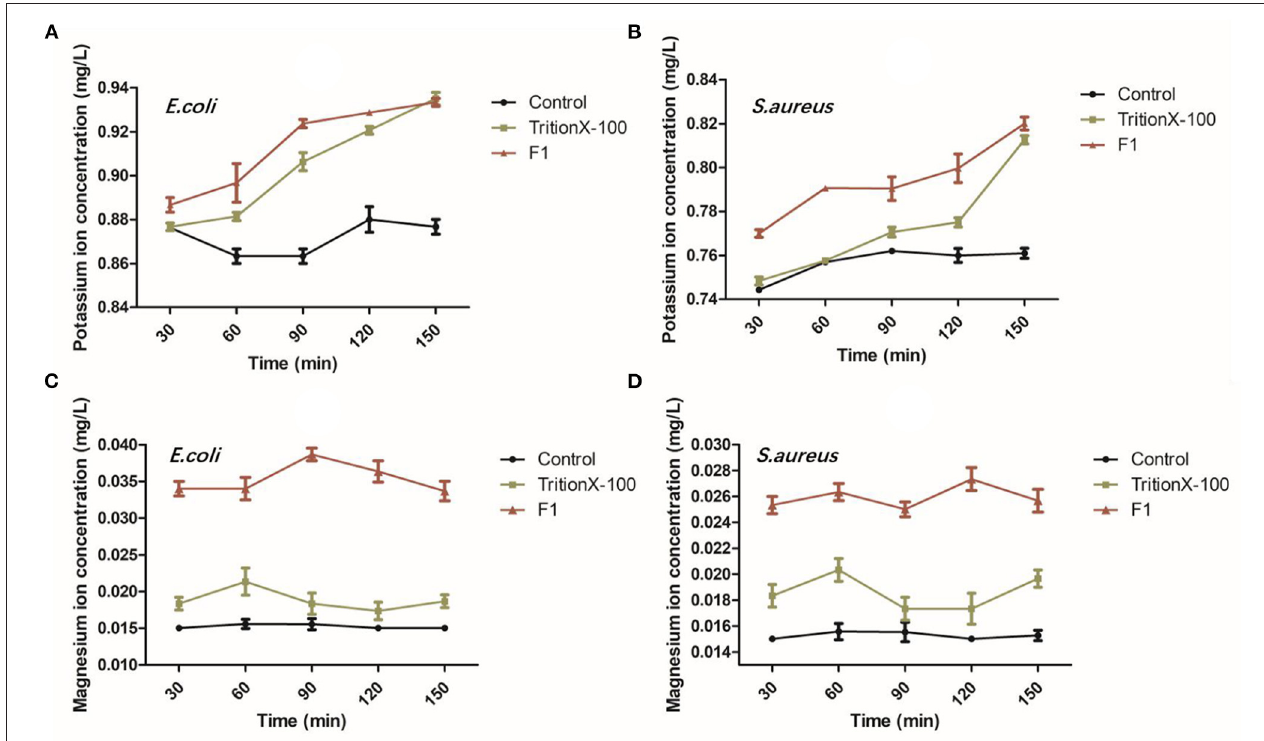
FIGURE 2 | Analysis of bacterial ion leakage after antimicrobial peptide F1 applied on E. coli and S. aureus. (A,C) As well as (B,D) show the leakage of potassium and magnesium ions after the antimicrobial peptide F1 acted on E. coli and S. aureus for 30, 60, 90, 120, and 150min, respectively.